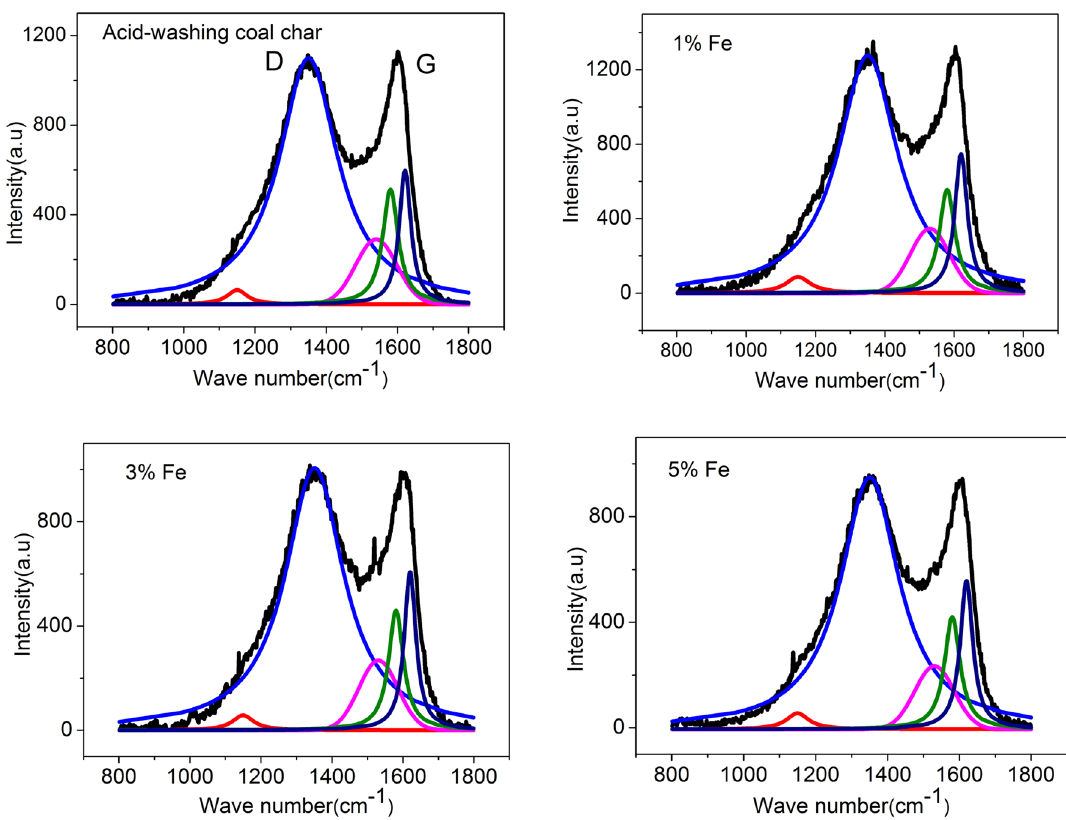
Figure 2. The fitting curve of the Raman